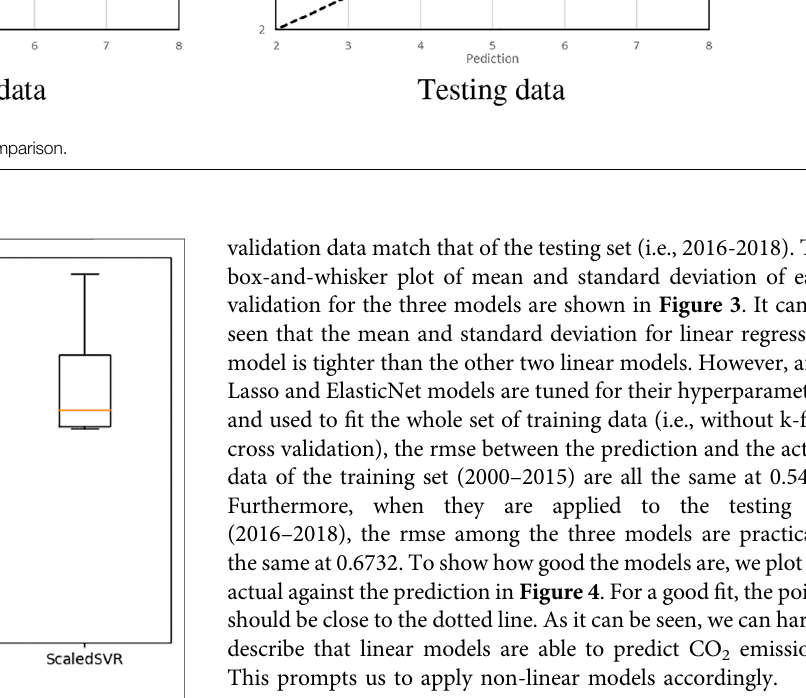
FIGURE 5 | Non-linear models